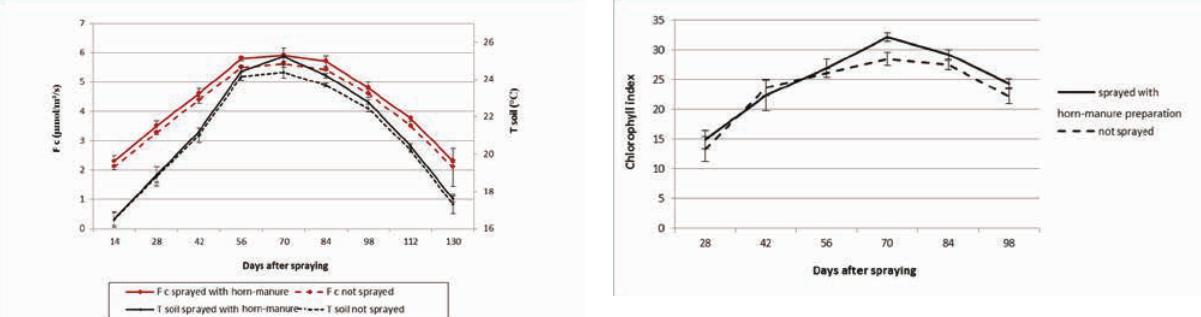
flux (F ) and soil temperature (T Figure 1: Soil CO 2 c spraying with horn-manure preparation